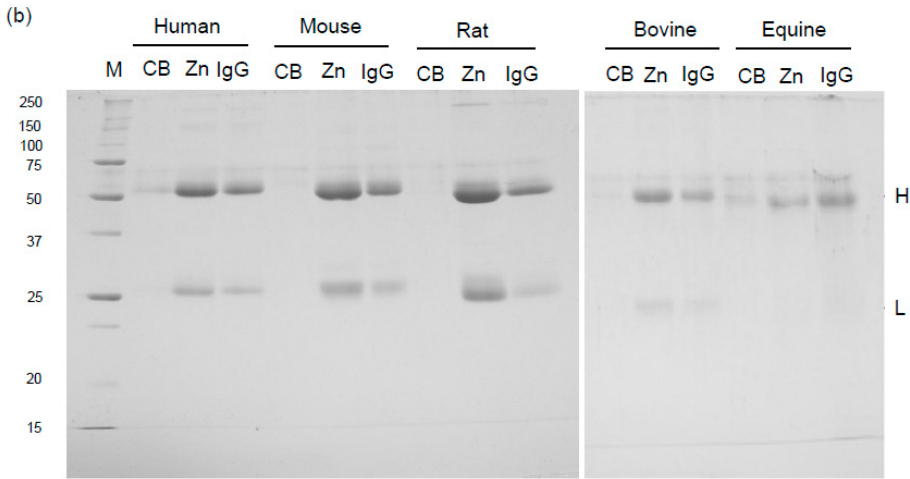
Figure 1. Binding of human and animal IgGs to Zn-beads. ( a ) Aliquots (1 mL) of IgG (25 µg) and Zn-beads (Zn) or CB in phosphate-buffered saline (PBS) were prepared (net volume of beads per sample: 20 µL each) and incubated at 4 °C overnight. The mixture was centrifuged at 14,000× g for 7 min and the supernatant (S) and pelleted beads (B) were analyzed by sodium dodecyl sulfate-polyacrylamide gel electrophoresis (SDS-PAGE) as described in the “Experimental Section”. Human IgG (IgG) was also applied to the gel (2 µg/lane) and the separated H and L subunits are denoted H and L, respectively. M represents marker proteins; ( b ) Animal IgG samples were treated as described in ( a ), and only the resultant beads were analyzed by SDS-PAGE. The H and L subunits from the various animal IgGs (2 µg each per lane) were denoted H and L. M represents marker proteins. Antibodies 2016 , 5 , 13